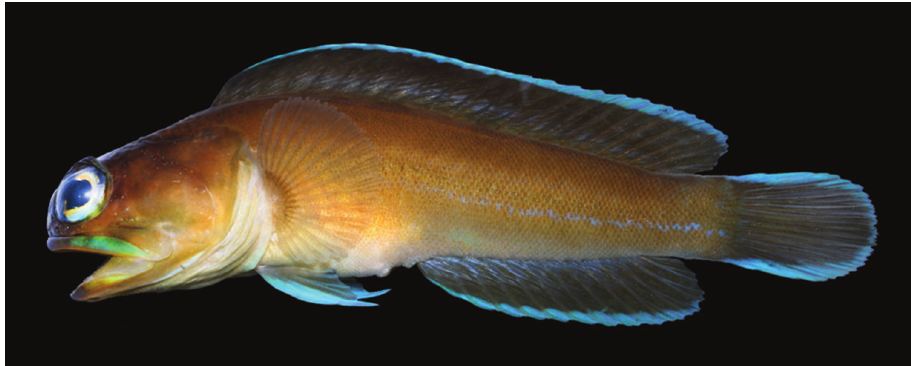
Figure 16. Opistognathus lonchurus , CIUFES 2361, 81.2 mm SL, female, Ilhas Escalvada, Guarapari, Espírito Santo, Brazil. Photograph by Raphael M.